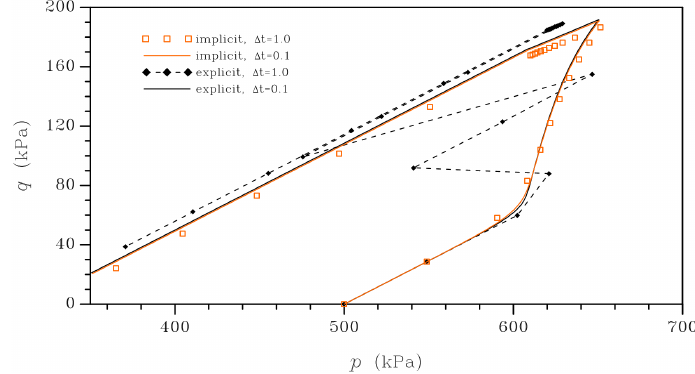
Figure 7. Test 3. Stress point evolution in the p − q